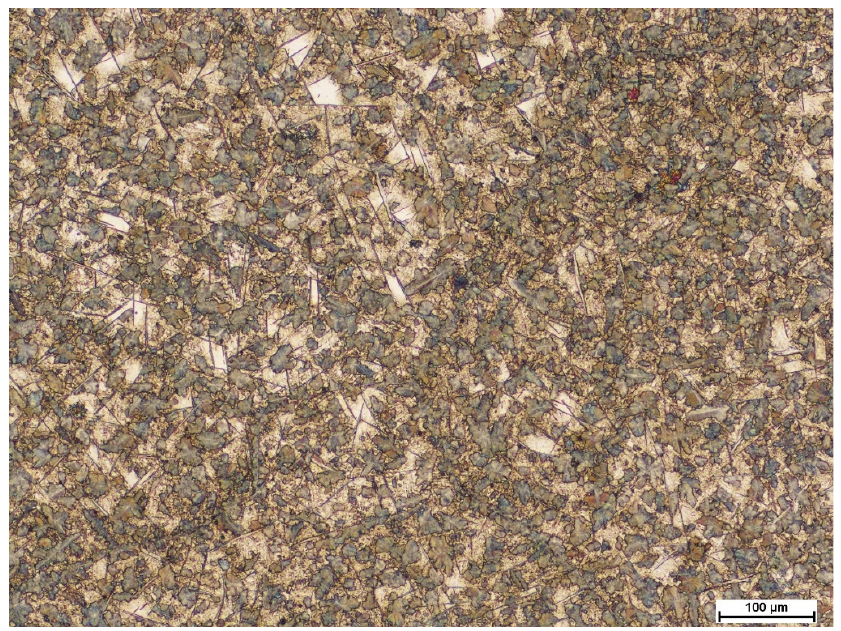
Figure 2. Microstructure of the X120Mn12 steel after isothermal annealing at 510 °C and cooling with the furnace. Visible diversified and refined microstructure morphology compared to the as-delivered condition (Figure 1). Etched state. LM.